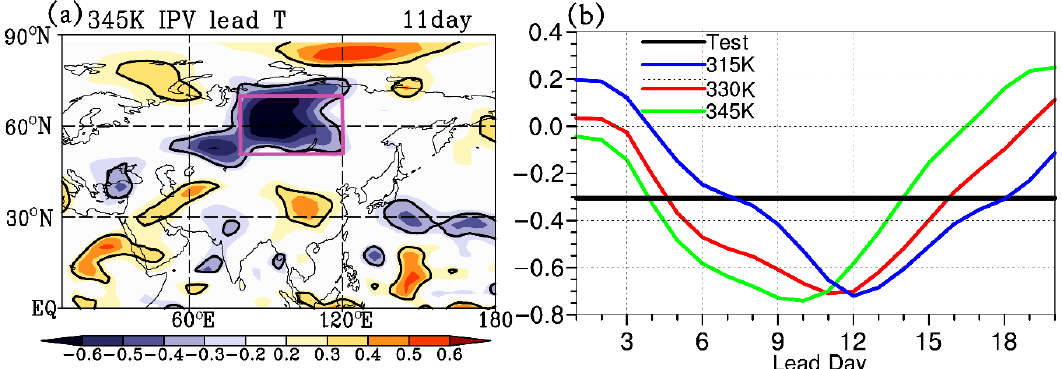
Figure 3. ( a ) The leading correlation coefficient map when 345 K isentropic PV is 11 days ahead of China’s surface temperature for the period from 1 January to 10 February in 2018 (the contour outlines the significant correlation regions with a 95% confidence level). ( b ) Leading correlation coe ffi cients between the daily isentropic PV series averaged over the northwestern region of Lake Baikal (80–120 ◦ E, 50–70 ◦ N) as shown in the box in ( a ) at 315 K (blue), 330 K (red) and 345 K (green) and the daily mean China near-surface air temperature series for the period from 1 January to 10 February (the thick horizontal black line indicates the 95% confidence